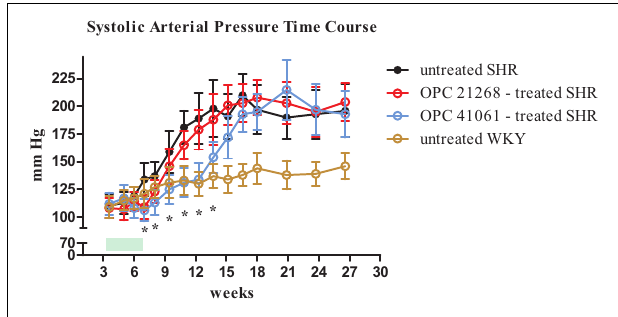
FIGURE 6 | Time course of systolic arterial pressure from 3 weeks (prehypertensive phase) until 27 weeks of age in four groups of female rats: untreated SHR ( n = 8, filled black circle), OPC 21268-treated SHR ( n = 10, open red circle), OPC 41061-treated SHR ( n = 10, open blue circle), and untreated WKY ( n = 12, open yellow circle). Green rectangle indicates the active period of drug treatment (24 days). Data are expressed as means ± SD. * p <